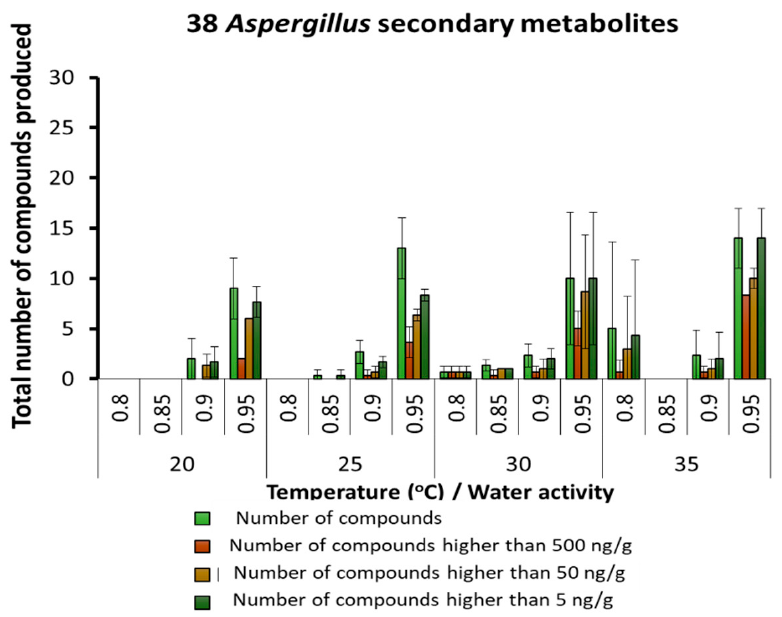
Figure 3. Summary of the predominant secondary metabolites ( µ g/g) and their concentrations detected and produced by species of the Aspergillus genus in maize grain stored under different temperature × water activity conditions; Bars represent the Standard Error of the mean. Table 2. Summary of the major secondary metabolites (ng/g) of Aspergillus species present in the maize under different temperature x water activity conditions. The conditions highlighted in green (low concentrations), yellow (medium concentrations) and red (highest concentrations) were found. LoD: Limit of Detection. Maize Aspergillus secondary metabolites (ng/g)